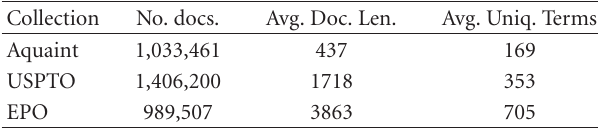
Table 1: Summary statistics from representative real-world collec- tions that we used as templates for our synthetic data